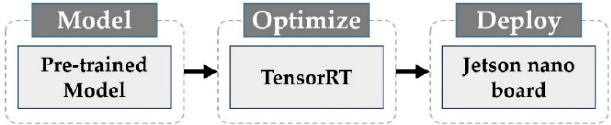
Figure 12. Deep learning system’s end-to-end flow.